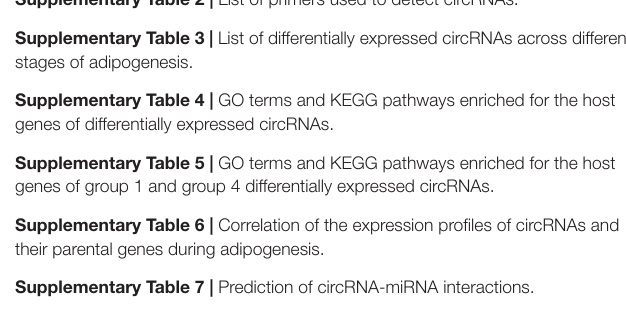
Supplementary Table 1 | List of circRNAs identified by RNA-seq in white adipogenesis. Supplementary Table 2 | List of primers used to detect circRNAs. Supplementary Table 3 | List of differentially expressed circRNAs across different stages of adipogenesis.